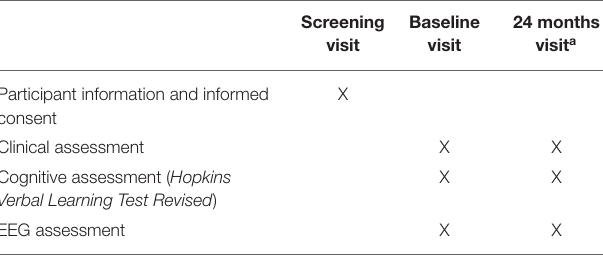
TABLE 1 | Visits and study procedures in CHR-P individuals and HC.